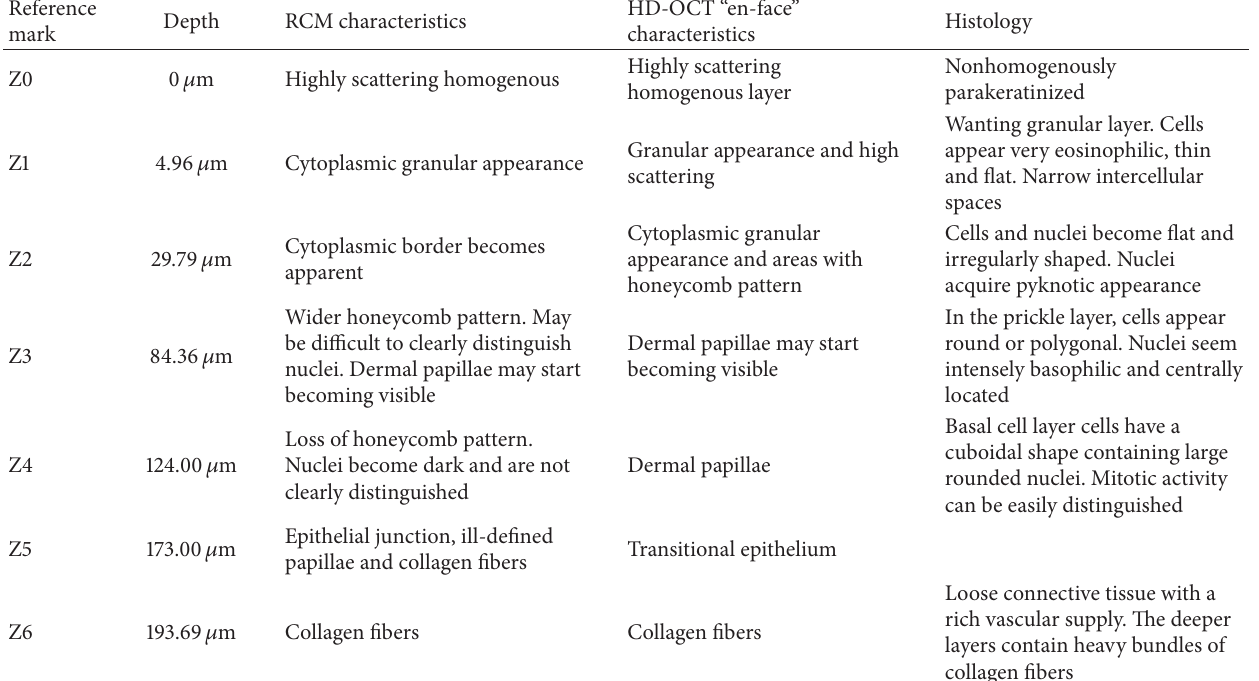
Table 3: Reflectance confocal microscopy, high-definition optical coherence tomography, and conventional histology morphological char- acteristics in lip mucosa according to tissue